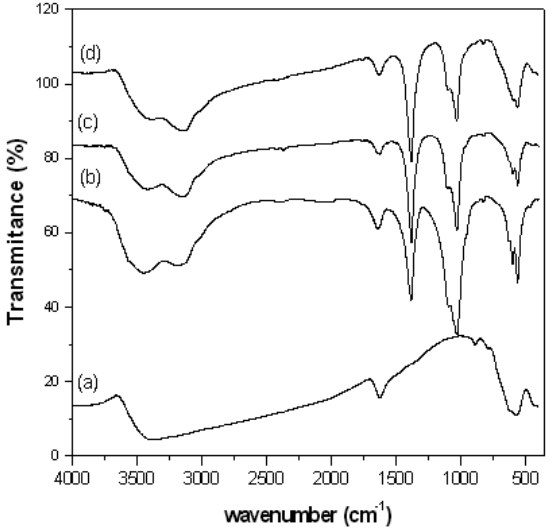
Fig. 2 – Infrared absorption spectra: (a) IOMP; (b) HAp; (c) IOPM/ HAp = 0 . 7 and (d) IOPM/HAp = 3 .